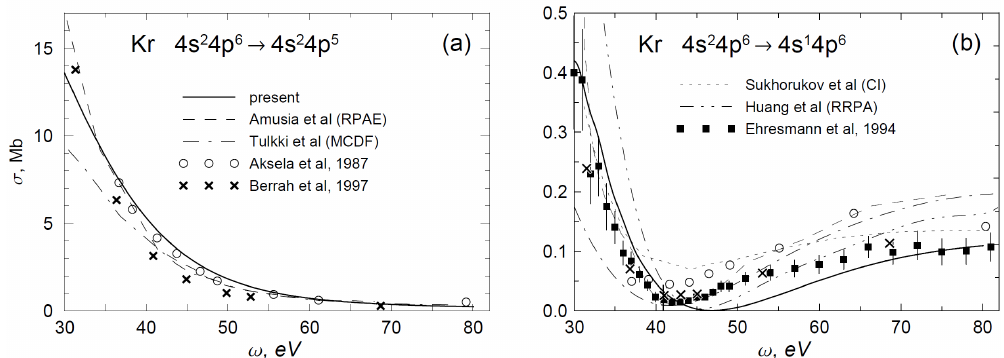
Figure 5. Photoionization cross-sections for the 4 p ( a ) and 4 s ( b ) level of Kr. Solid curves — present calculations. Other curves: random phase approximation with exchange (RPAE) from [37] (dashed curve), multichannel Dirac-Fock (MCDF) approximation from [38] (dash-dotted curve), configuration interaction (CI) approximation from [39] (short-dashed curve), relativistic random phase approximation (RRPA) from [40] (dash-dot-dot curve). Experimental data from [41] (squares), [42] (crosses), and [43] (open